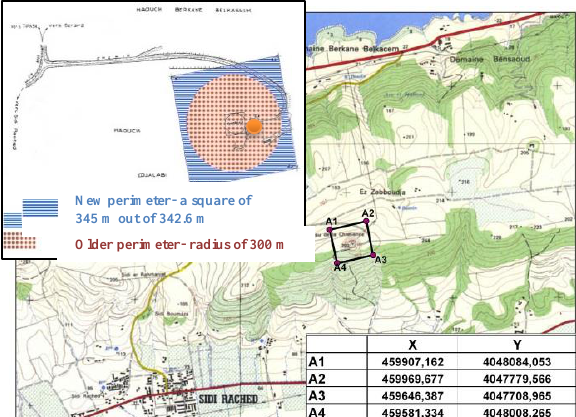
Figure 3. The limits of the Mausoleum Buffer Zone, (PPMVSA,